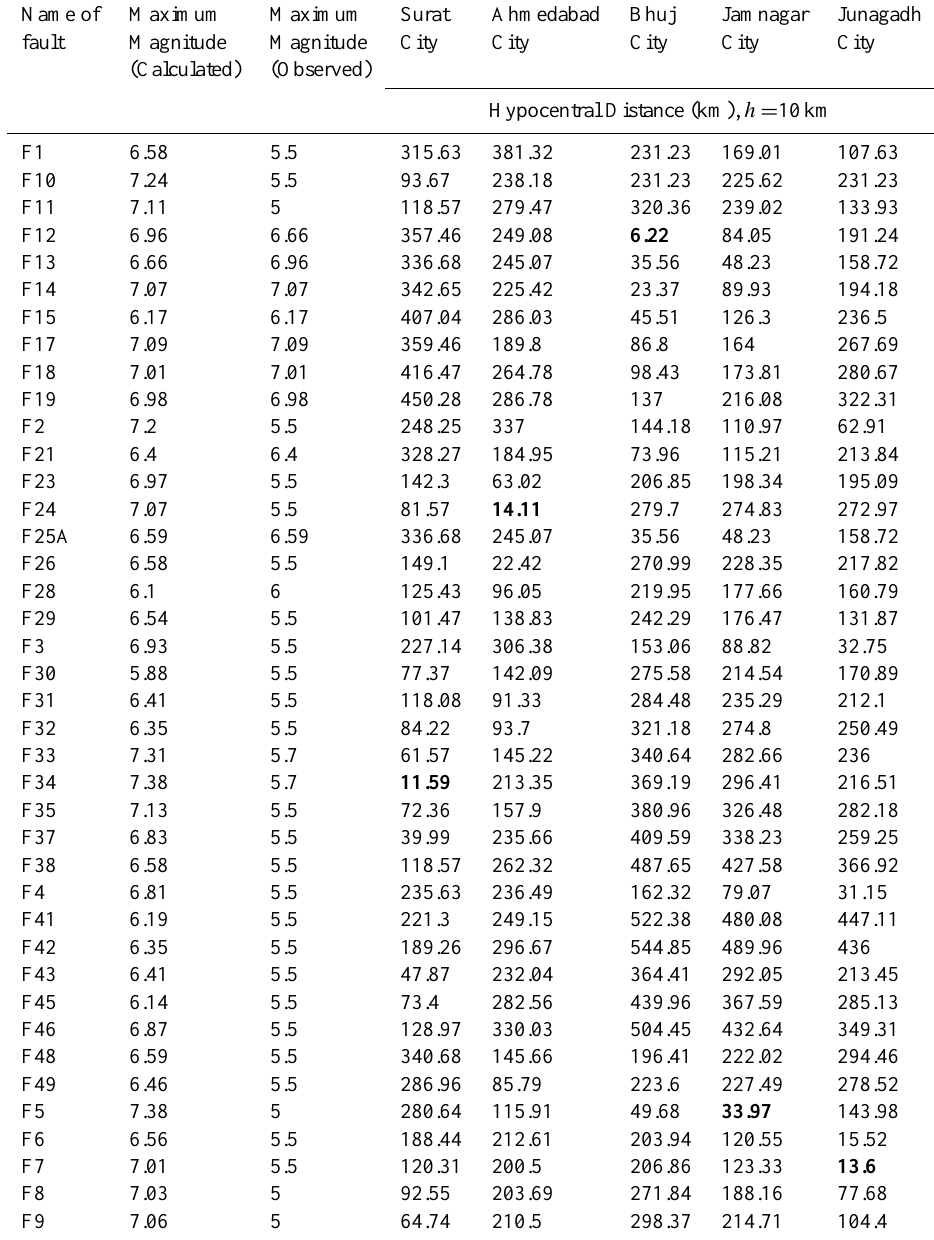
Table 4. Deterministic scenarios for various cities under consideration in the present